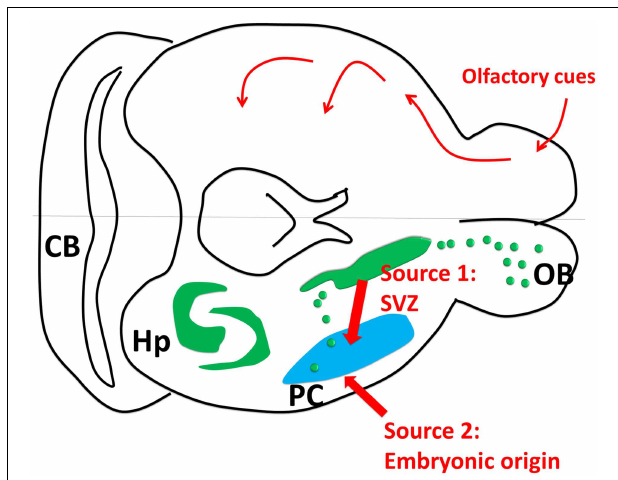
FIGURE 1 | Piriform cortex neurogenesis. The upper part of the cartoon shows the olfactory sensory pathway. The olfactory bulb transmits the signal to the piriform cortex as the first relay, and then to other connected regions such as hypothalamus, endorhinal cortex and amygdala. The lower part of the cartoon shows the neurogenic sites including hippocampus and subventricular zone (SVZ). Source 1: SVZ gives birth to some new neurons in olfactory bulb and piriform cortex through rostral and caudal migration streams. Source 2: Some new neurons in PC are generated embryonically (Figure 1 was modified from Klempin et al.,